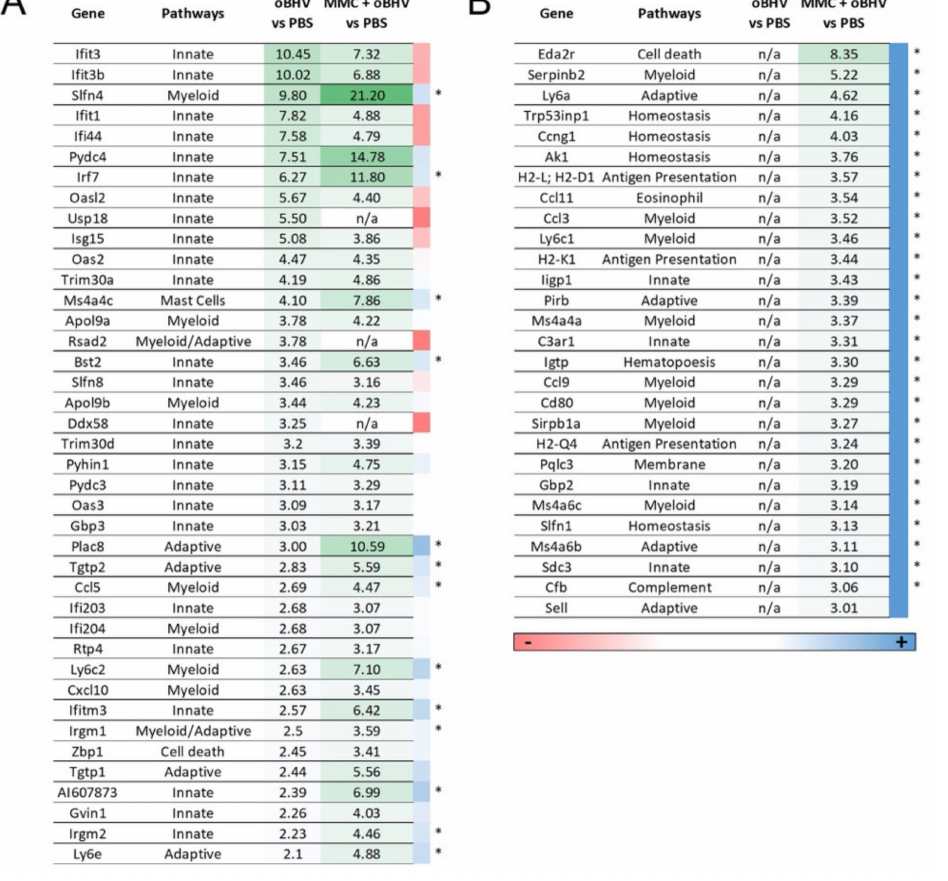
Figure 7. Transcriptional profiling of B16-C10 tumors treated with PBS, oBHV or MMC + oBHV showing trends in changes in expression with treatment. ( A ) Genes significantly upregulated by oBHV expressed as fold expression over PBS, compared to observed fold changes in MMC + oBHV treatment. ( B ) Genes significantly upregulated by MMC + oBHV expressed as fold expression over PBS that are not upregulated by oBHV alone. Genes suppressed or enhanced by addition of MMC indicated via color scale (red—suppressed, blue—enhanced). * indicates significant difference when signal data is compared directly ( p <